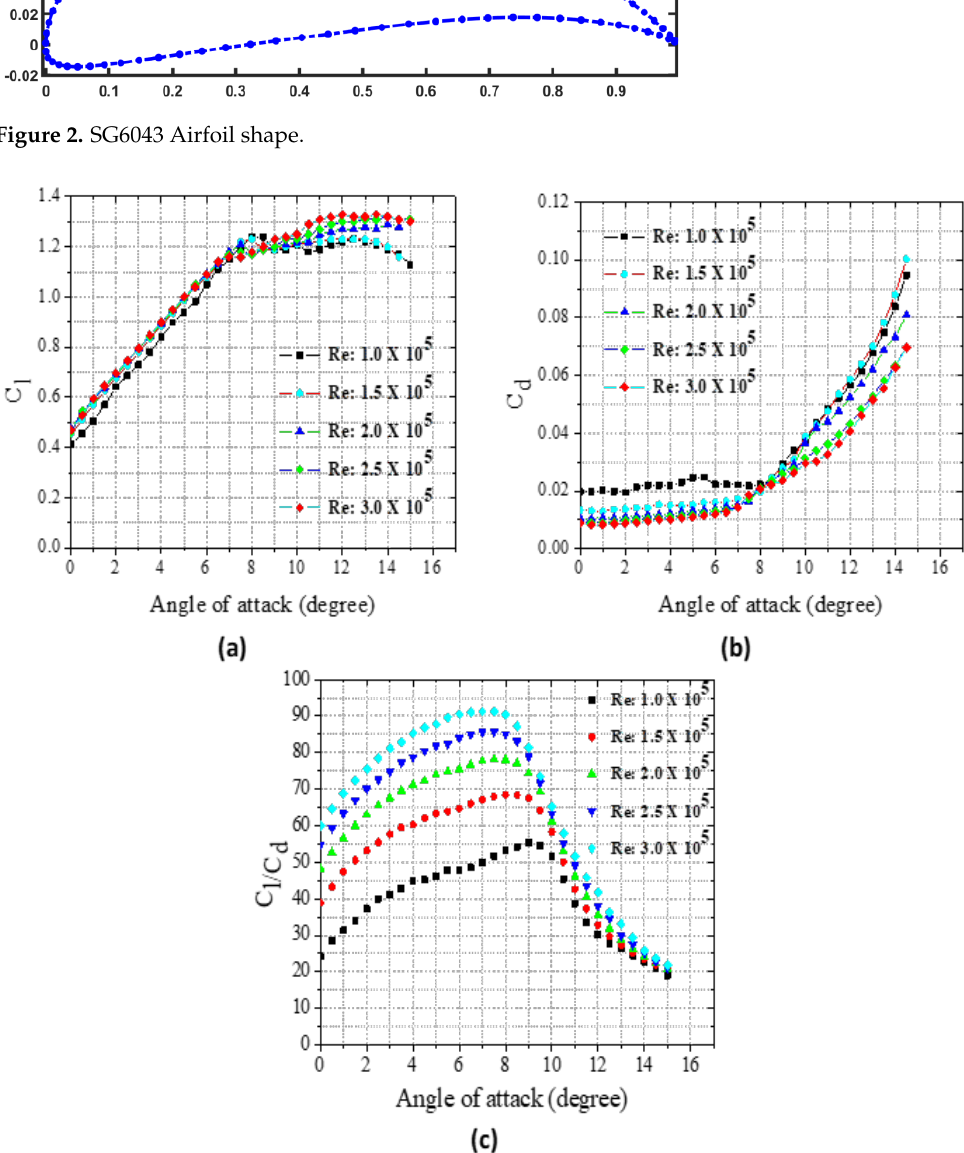
Figure 3. NACA 4412 airfoils ( a ) lift coefficients; ( b ) drag coefficients; ( c ) lift-to-drag ratio at the various angle of attack.